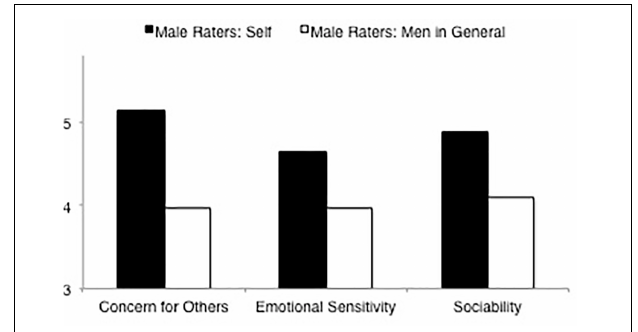
FIGURE 6 | Ratings of communality dimensions (concern for others, emotional sensitivity, sociability) by male raters rating self and men in general.